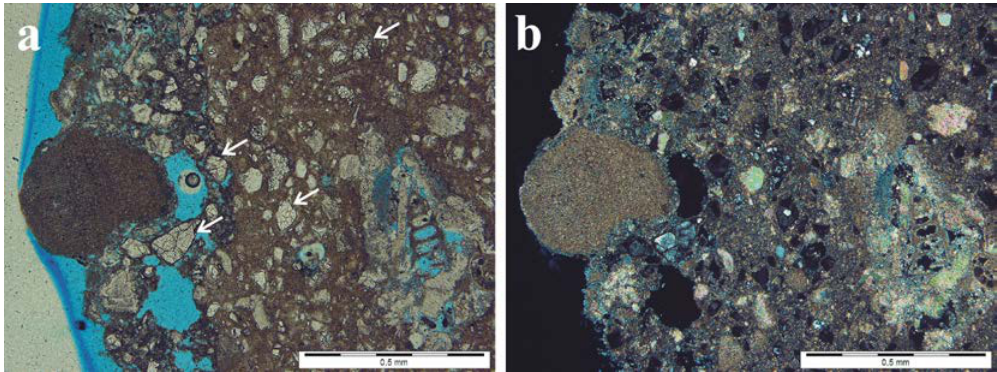
Figure 2. Microphotographs of the sample KD-M-4-2 taken from the wall in places covered and/or filled with bright cement render, above the pavement level; cement clinker clusters are marked with the arrow (one polar ( a ) and crossed polars ( b )).